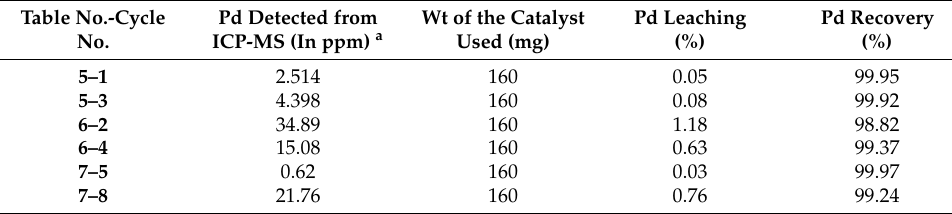
Table 13. Pd leaching (%) after 2a -catalyzed Stille coupling of aryl bromides from ICP-MS. Table No.-Cycle